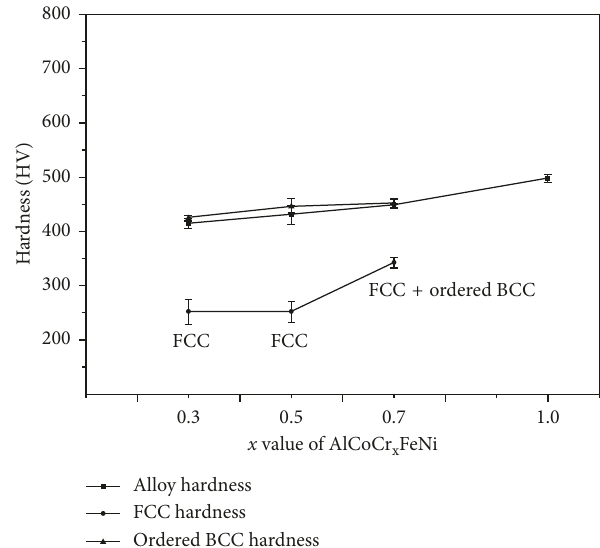
Figure 4: Variations in alloy hardness, ordered BCC phase hardness, and FCC phase hardness of the AlCoCr x FeNi alloys.